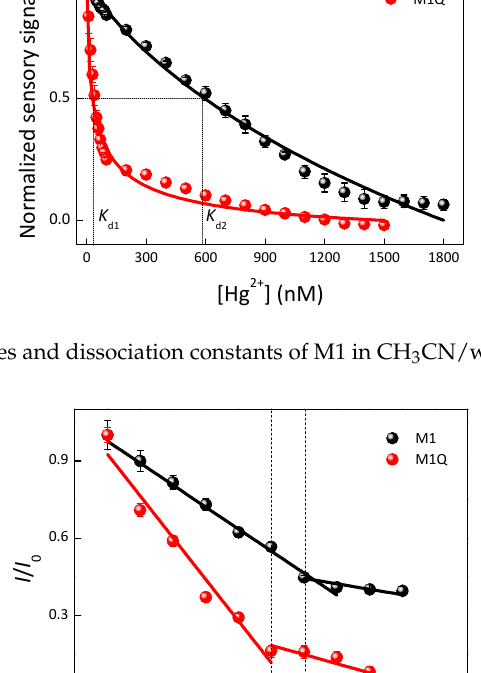
Figure 3. Titration curves and dissociation constants of M1 in CH 3 CN/water and M1Q in water.